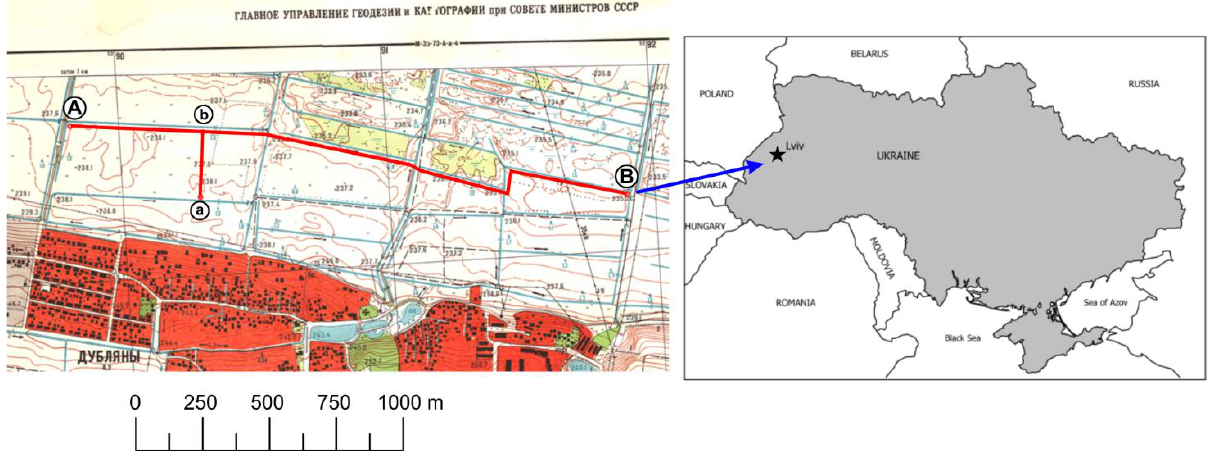
Figure 1. Location of the transects (A – B, a – b) within the peatland in Dublany near Lviv. Source of the map: Central Office of Geodesy and Cartography of the Soviet Union Map Sheet M-35-73-A- B -4 (1991), co-ordinate system